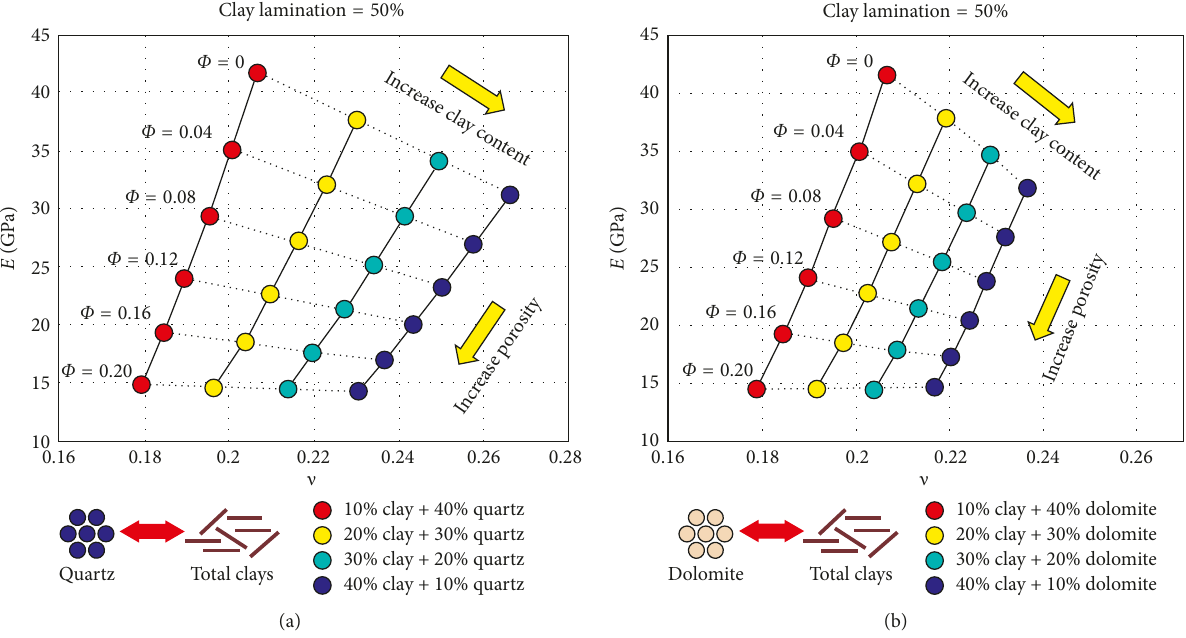
Figure 3: Crossplots of Young’s modulus and Poisson’s ratio, showing the degree of clay. Mineralogical substitution occurs between (a) quartz and clay and (b) dolomite and